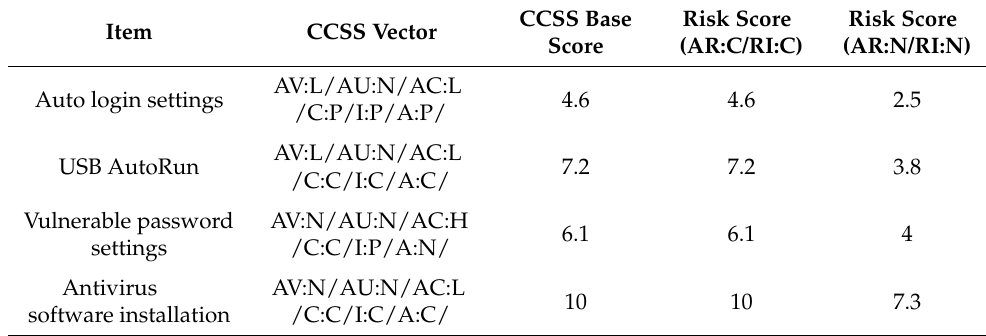
Table 1. Example table of risk-scoring